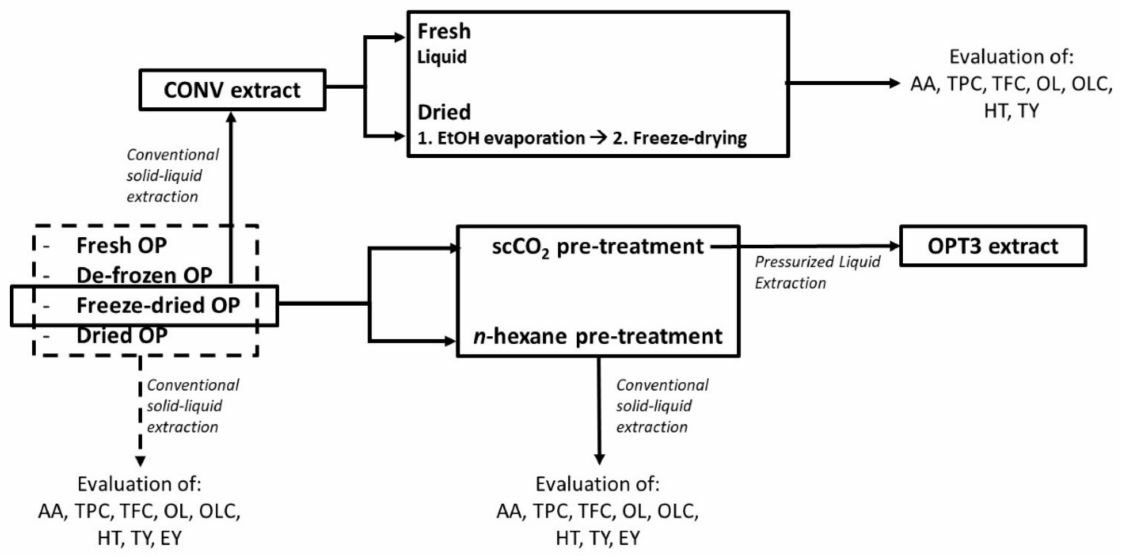
Figure 5. Experimental procedure followed for the phenolic extraction of the differently pretreated olive pomace (OP) and the effect of the extract drying. All extracts were evaluated in terms of antioxidant activity (AA) and richness in total phenolic content (TPC), total flavonoid content (TFC), oleuropein (OL), oleacein (OLC), hydroxytyrosol (HT), and tyrosol (TY). The extracts derived by the differently pretreated OP were also evaluated in terms of extraction yield